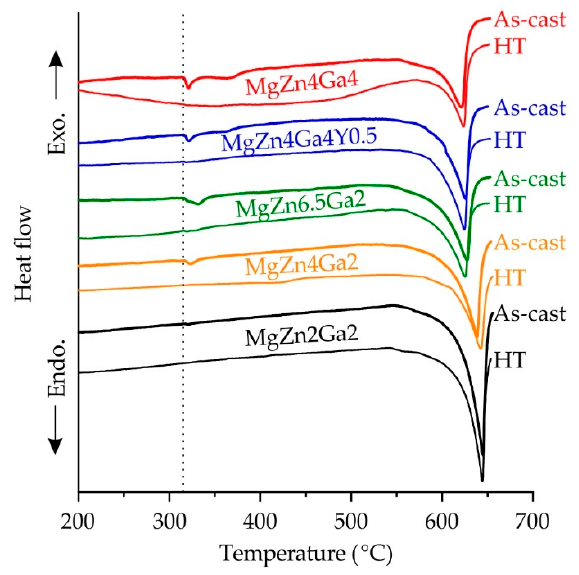
Figure 6. DSC heating curves for Mg–Zn–Ga–(Y) alloys in the as-cast condition and after HT. The microstructures along the direction parallel to the ED of the Mg–Zn–Ga–(Y) alloys extruded at 150 and 200 ◦ C are shown in Figure 3. The alloys extruded at 250 ◦ C had similar microstructures (not shown here). In the extruded alloys, the intermetallic phases, which did not fully dissolve during HT, were elongated towards the ED and were significantly fragmented. MgZn2Ga2 and MgZn4Ga2, which had a single-phase microstructure after HT, were the alloys with no large intermetallic phases observed. The insets in Figure 3 (pink boxes) show the microstructures of the extruded alloys at high magnification. Small precipitates of secondary phases were formed during extrusion via a stress-induced precipitation mechanism in the α -Mg matrix. TEM images of the hot-extruded Mg–Zn–Ga–(Y) alloys are shown in Figure 7. A large amount of near-spherical precipitates, 100–200 nm in diameter, were observed in the MgZn4Ga4 alloy extruded at 200 ◦ C (Figure 7a). The precipitates were located both inside the grains and at the grain boundaries. According to the EDS results, the compositions of the precipitates are close to the Mg 5 Ga 2 and Mg 12 Zn 13 phases, which form agglomerates, and Figure 7a also shows these agglomerates at higher magnification. In the MgZn2Ga2 alloy extruded at 150 ◦ C, only Mg–Ga precipitates were found, but their compositions and sizes were different (Figure 7b). Most of the precipitates had a size of 20–50 nm and their composition was close to that of Mg 5 Ga 2 . However, large precipitates (up to 1 µ m) and compositions close to Mg 2 Ga 5 or MgGa were also observed, but their volume fraction was low. The Mg 5 Ga 2 precipitates also formed agglomerates. Thus, the large fraction of small precipitates must provide high mechanical